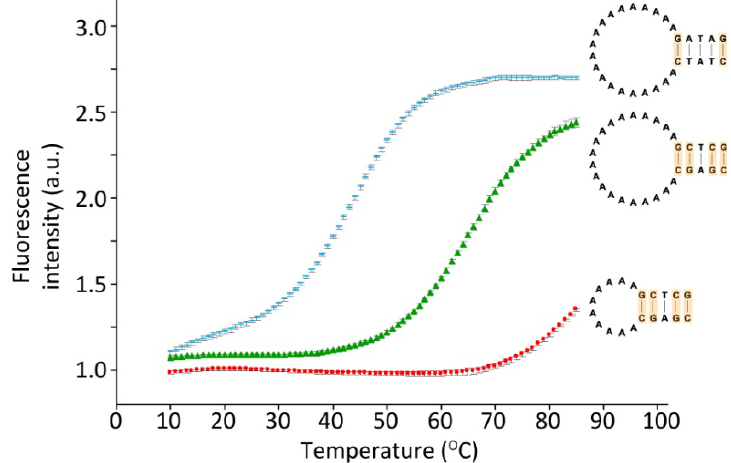
Figure 3. Melting curves for hairpins differing in the stem sequence and/or the loop length: Hairpins with a 20 bases long poly-A loop and a five base pair stem of which four base pairs are G-C (green), hairpins with a 20 bases long poly-A loop, where the G-C base pair content of the five base-pair stem is decreased to two (blue), or hairpins with only 10 A’s in the loop and four G-C base-pairs out of five in the stem (red). Standard deviations of fluorescence values are shown as error bars. The sequence of the different hairpins is as